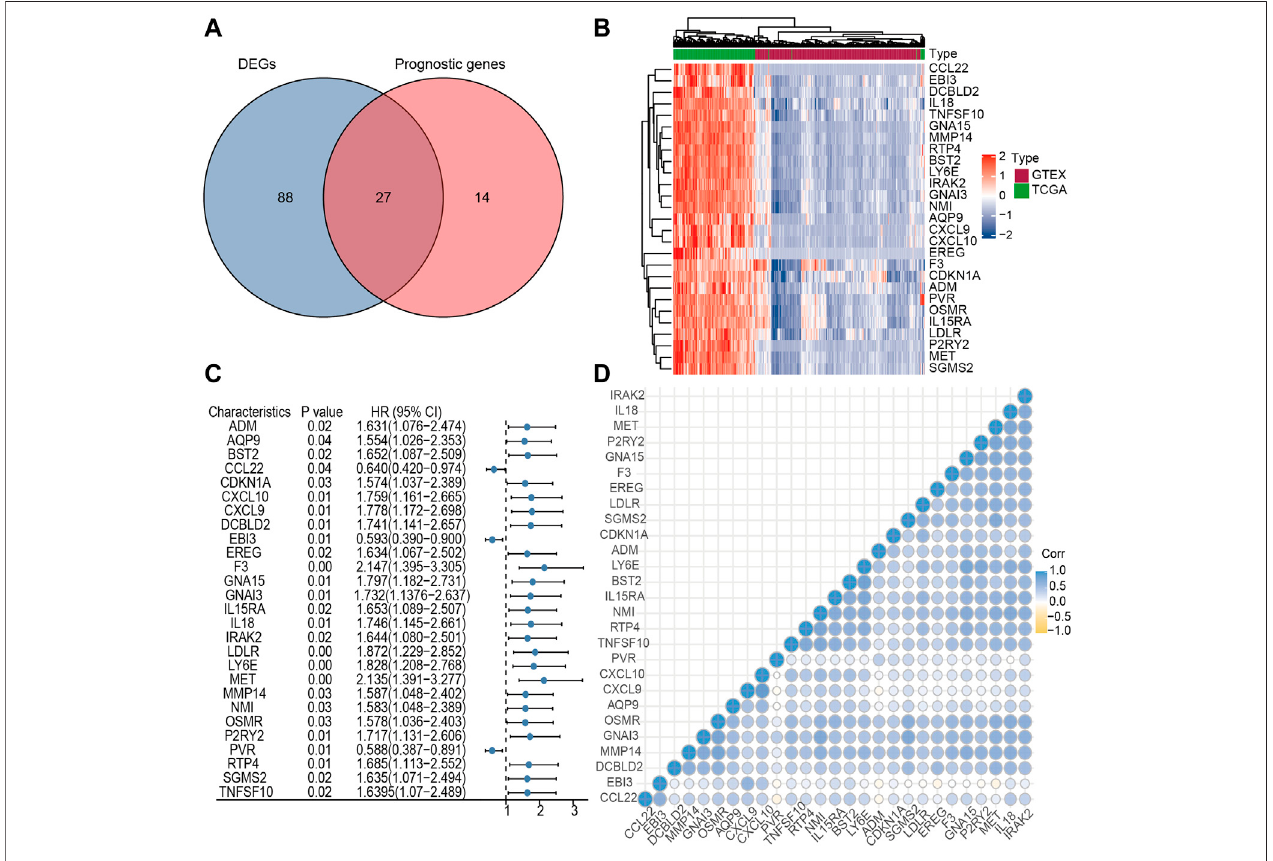
FIGURE 1 | Identi fi cation of candidate in fl ammatory response-related genes in PC. (A) Venn diagram of DEGs between TCGA and GTEx. (B) Heatmap of prognosis-related DEGs. (C) Forest plots of the association between 27 prognosis-related DEGs and OS. (D) Cross correlogram between the 27 candidate